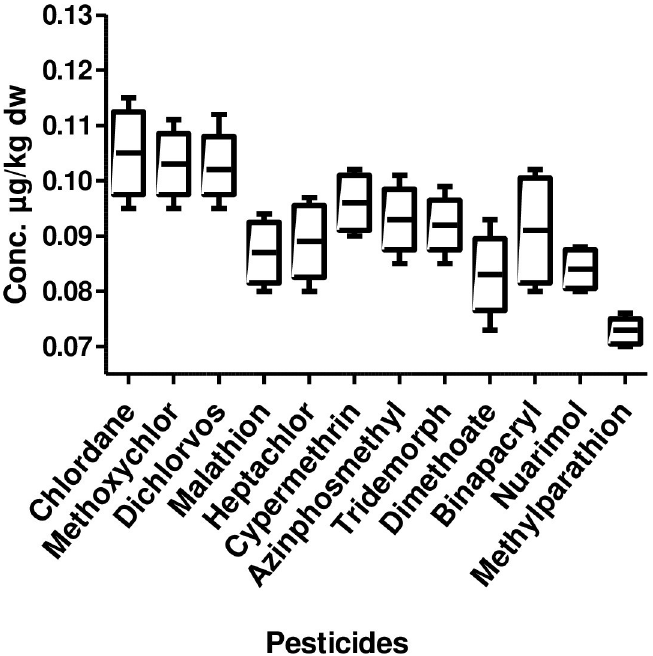
Fig 3. Box and whisker’s plot of pesticide residues in sediment samples from lower stretch of river